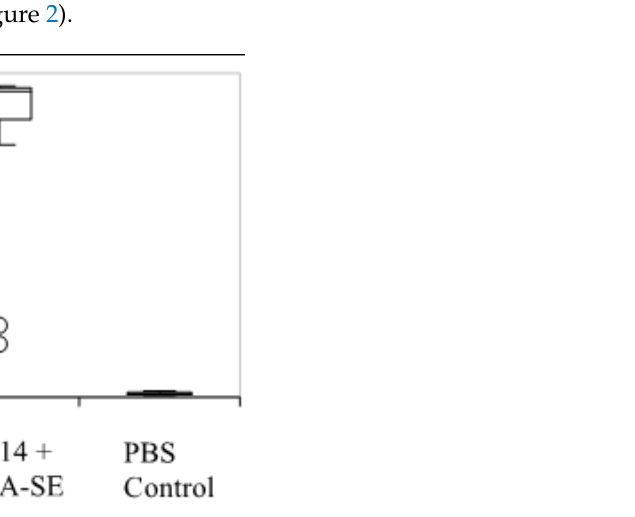
Table 1. Sm14 vaccination does not induce changes in pregnancy parameters.